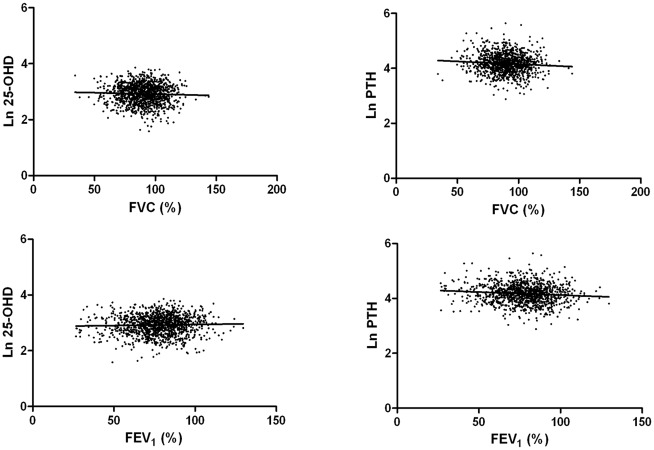
Relationship between 25-hydroxyvitamin D, parathyroid hormone levels and lung function.Log 25-OHD: ß for FVC (%), - 0.04, P = 0.16; ß for FEV1 (%), 0.03, P = 0.24. Log PTH: ß for FVC (%), - 0.08, P = 0.01; ß for FEV1 (%), - 0.10, P = 0.001.